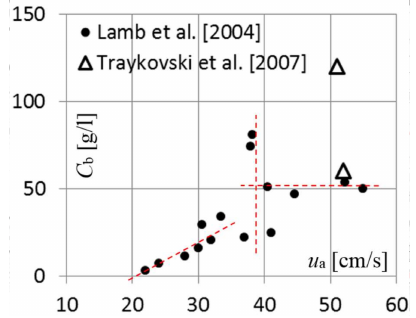
Figure 3. Equilibrium near-bed concentration ( C b ) as a function of wave speed ( u a ) measured in the laboratory [23], Table 1. Also shown are field data (triangles) [1]. Dashed lines indicate different regimes, as discussed in the